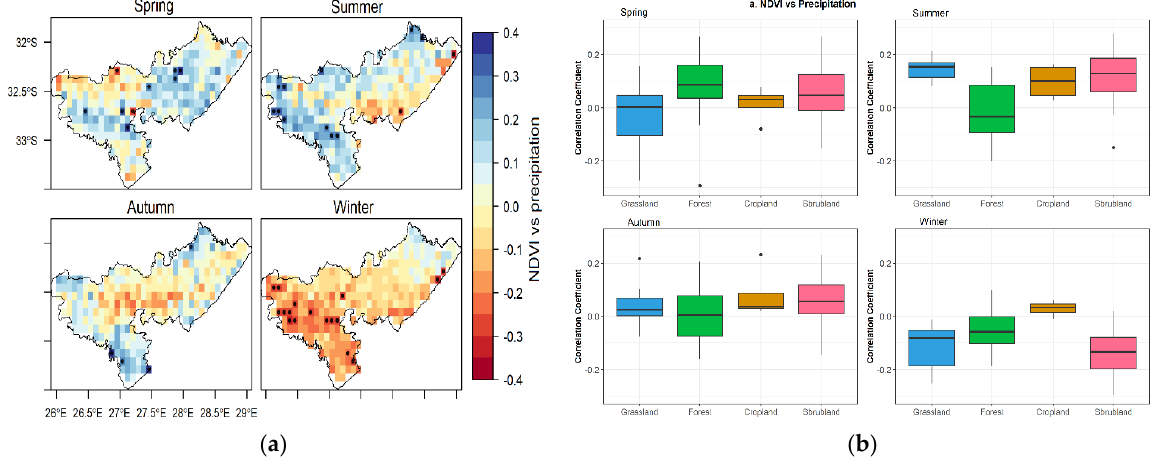
Figure 6. ( a ) Pixel-wise partial correlation coefficients between the NDVI3g and the ERA5-Land precipitation for Amathole District Municipality; and ( b ) boxplots of correlation for vegetation types. The stipplings are for pixels with statistical significance ( p -value < 0.05).